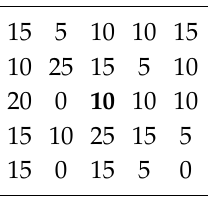
the neighborhood of the location l = ( 3,3 ) of diameter d = 3. Figure 2. Sample data grids at time stamp t and t − 1 highlighting an instance sample at location l = ( 3,3 ) and a diameter d = 3 for the